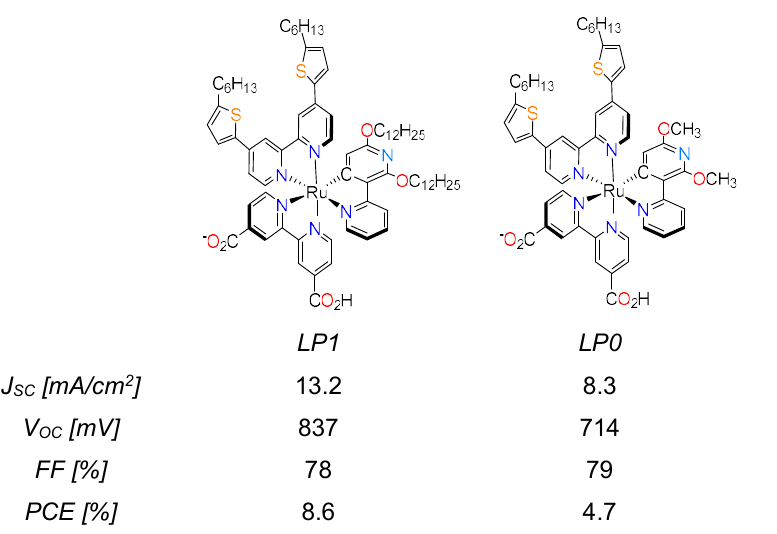
Figure 18 . Improved performance of LP1 in comparison to LP0. An electrolyte based on Figure 18. Improved performance of LP1 in comparison to LP0. An electrolyte based on [Co(phen) 3 ] 2+/3+ [Co(phen) 3 ] 2+/3+ redox was used [113] . redox was used [113] .